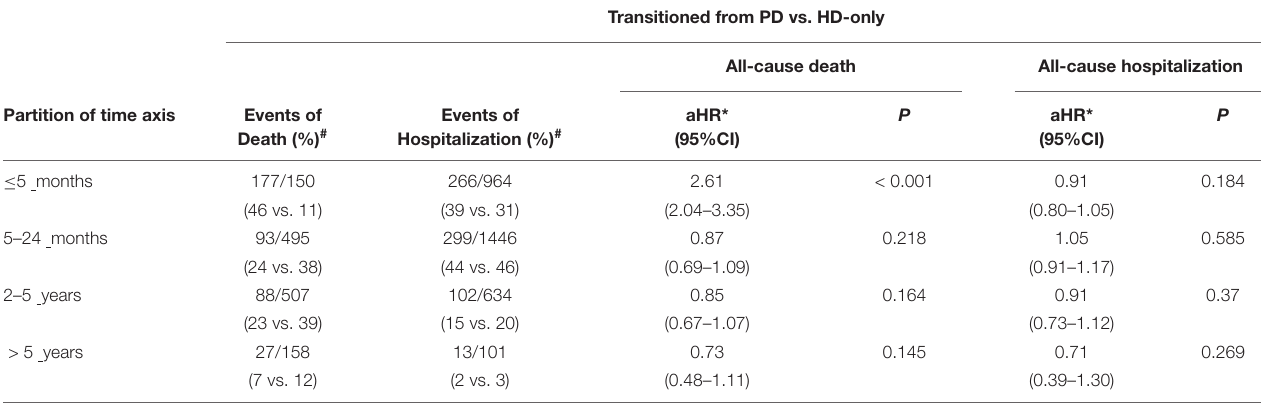
TABLE 4 | Outcome analysis of mortality and hospitalization by times axis in hemodialysis patients.